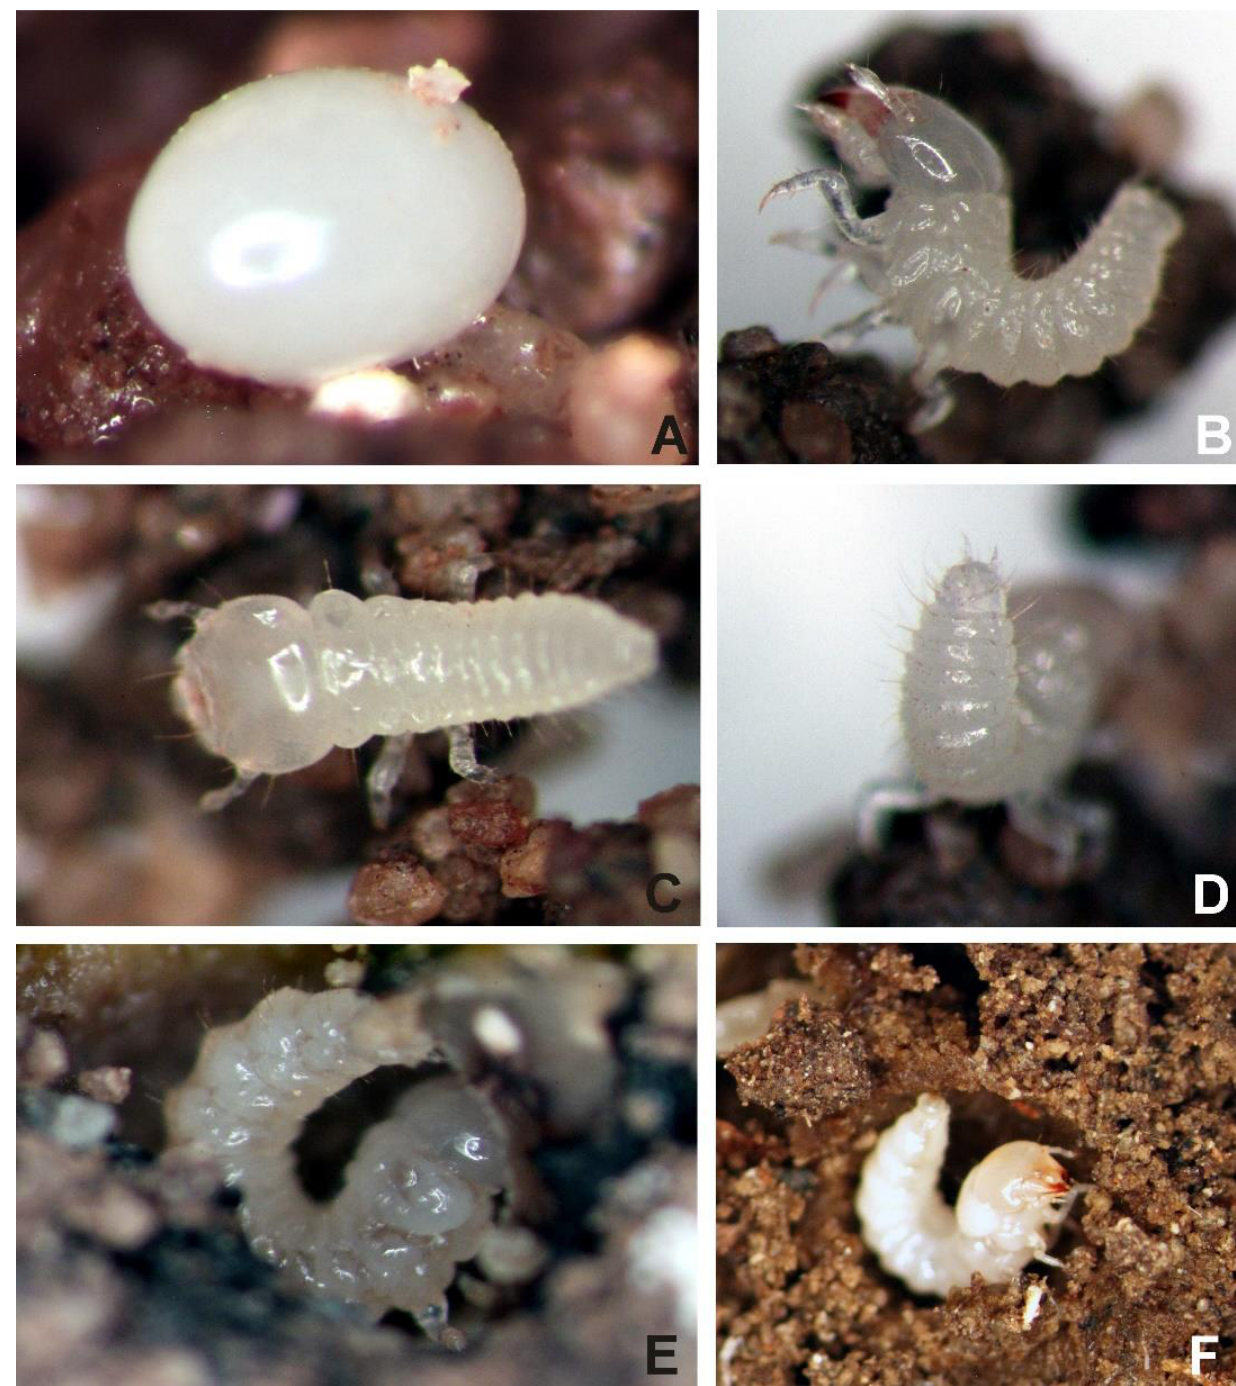
Figure 1. Leiodes cinnamomea . ( A ) Egg. ( B ) Larva of the first instar with abdomen arching up. Habitus of larva of the second instar feeding hymenium of Tuber aestivum . ( C , D ) Habitus od larva of the second instar using pygopode for moving. ( E , F ) Larva in dorsal view with abdomen arching up making cocoon.